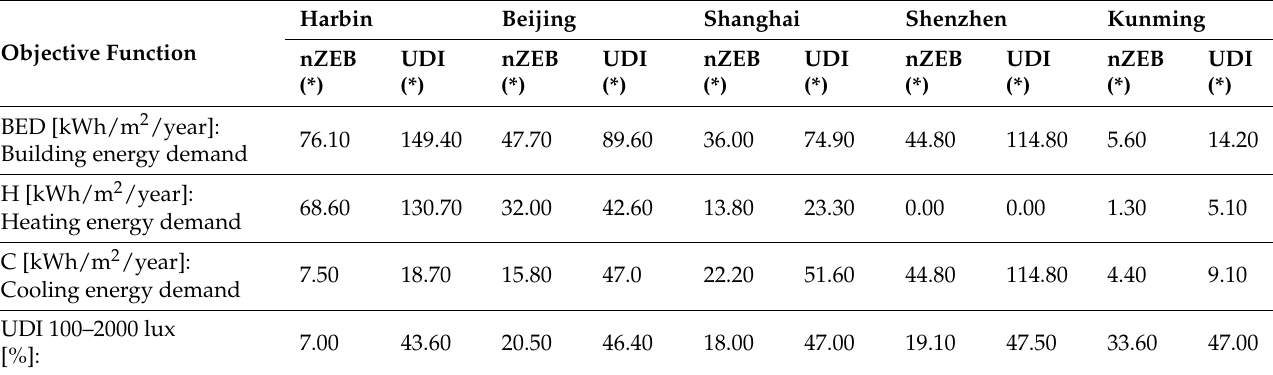
Table 18. Performance indicators of the optimal